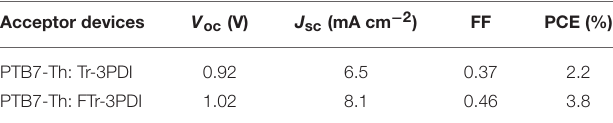
TABLE 2 | Photovoltaic parameters of OSCs based on PTB7-Th and truxene-PDI acceptors under AM1.5G illumination at 100 mW cm − 2 . Acceptor